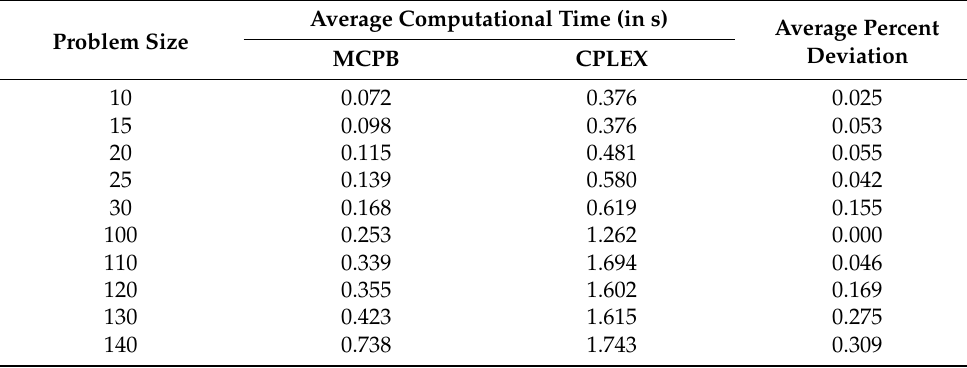
Table 8. The comparison of average computational time for MCPB and